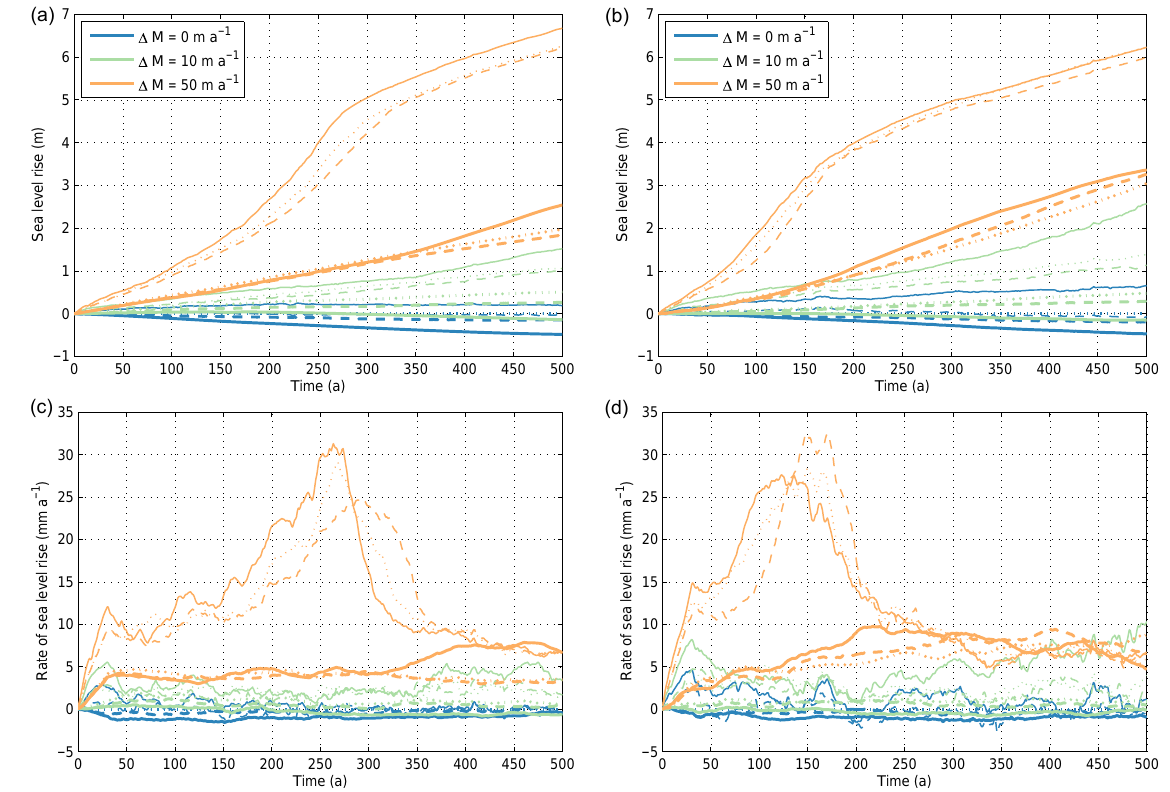
Figure 7. Evolution of sea-level contribution (a, b) and rate of sea-level rise (c, d) as a function of basal melting underneath ice shelves and background temperature change for the 25km (a, c) and 40km (b, d) spatial resolutions. Atmospheric temperature forcing is as follows: 0 ◦ C (dotted), 2.2 ◦ C (dashed), and 8.5 ◦ C (solid line). The thick lines correspond to the SGL grounding-line flux, while the thin lines correspond to the TGL